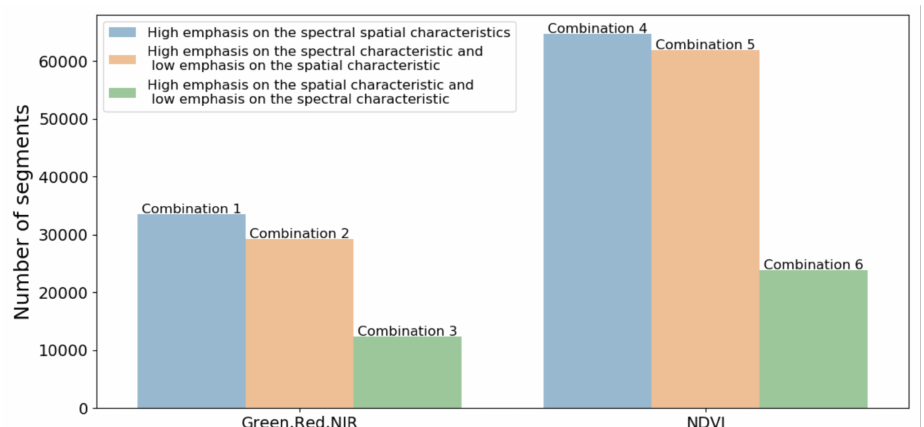
Figure 7. The number of output segments in part of the study area created using the mean shift algorithm and each one of the combinations (detailed in Table 1).